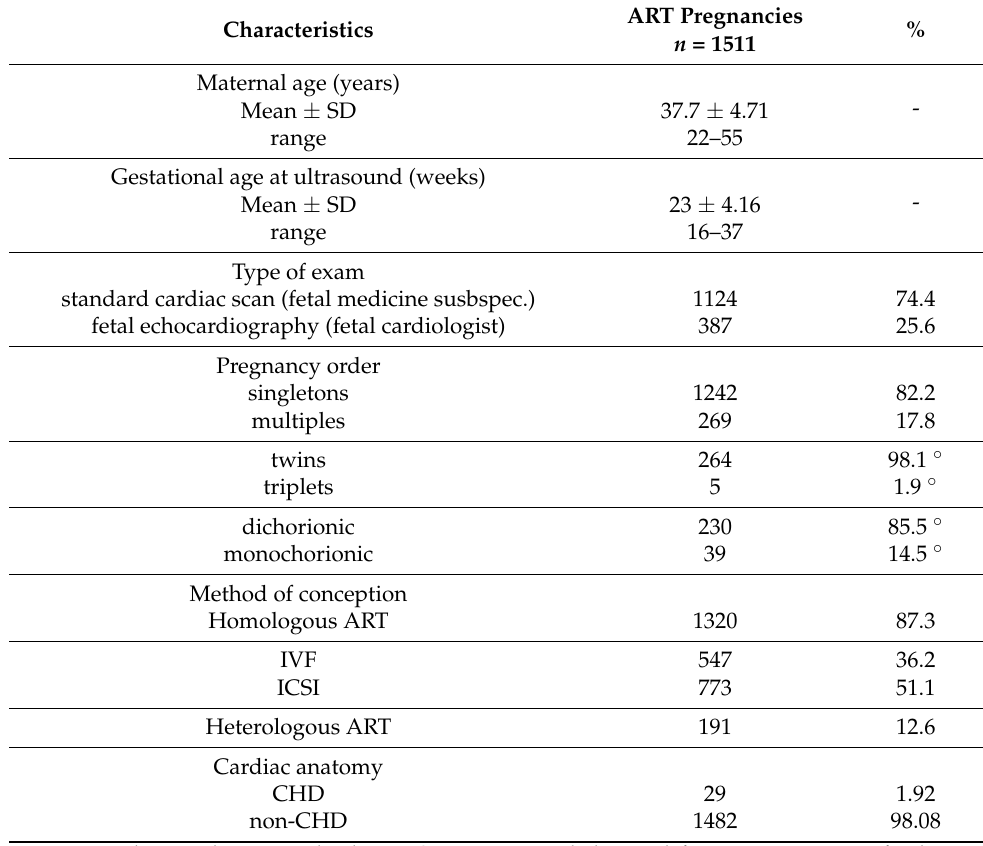
Table 1. The characteristics of study population of ART pregnancies.